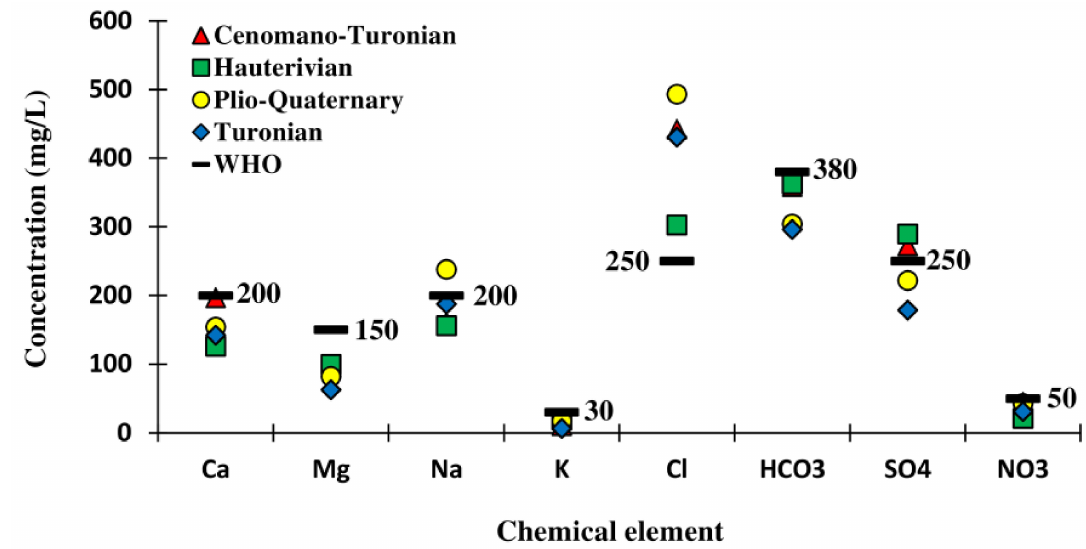
Figure 16. Comparison of chemical element contents (campaign of 2020) with the World Health Organization (WHO) standard